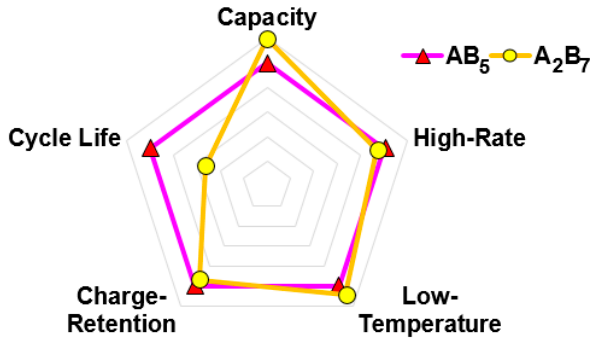
Figure 12. Sealed-cell performance comparison between cells made with the conventional AB 5 and new A 2 B 7 -based superlattice MH alloys.